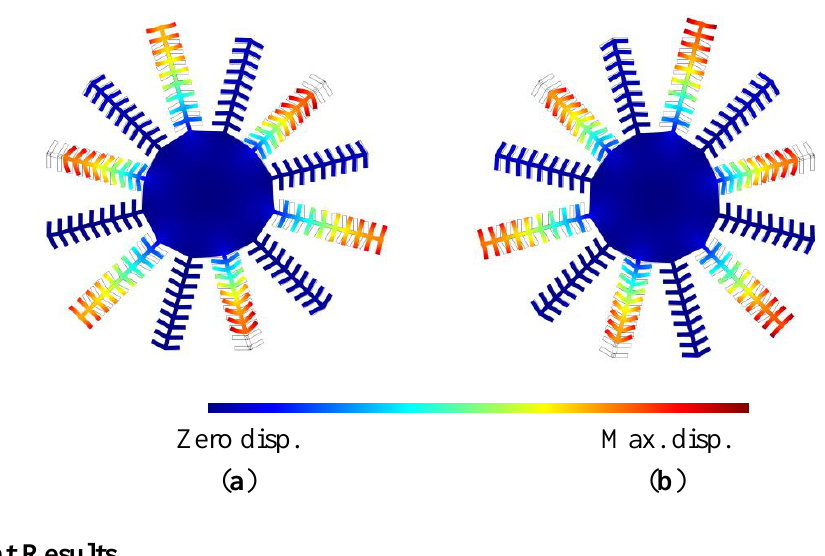
Figure 10. Mode shape of the ( a ) drive mode at 1.499271 MHz, and ( b ) sense mode at 1.499543 MHz, obtained by finite element simulations.